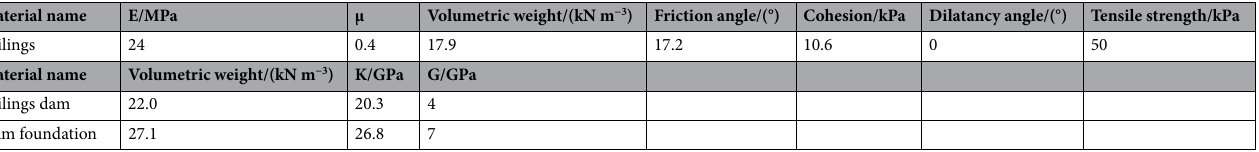
Table 2. Physical parameters of partition